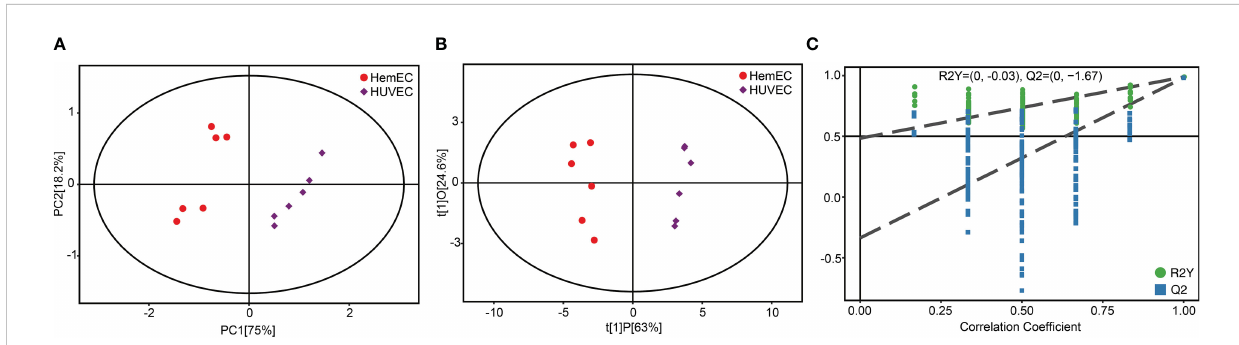
FIGURE 5 Score plots of principal component analysis (A) , orthogonal partial least squares discriminant analysis (B) and single-dimensional statistical analysis (C) between the HUVEC group and HemEC group by targeted metabolic